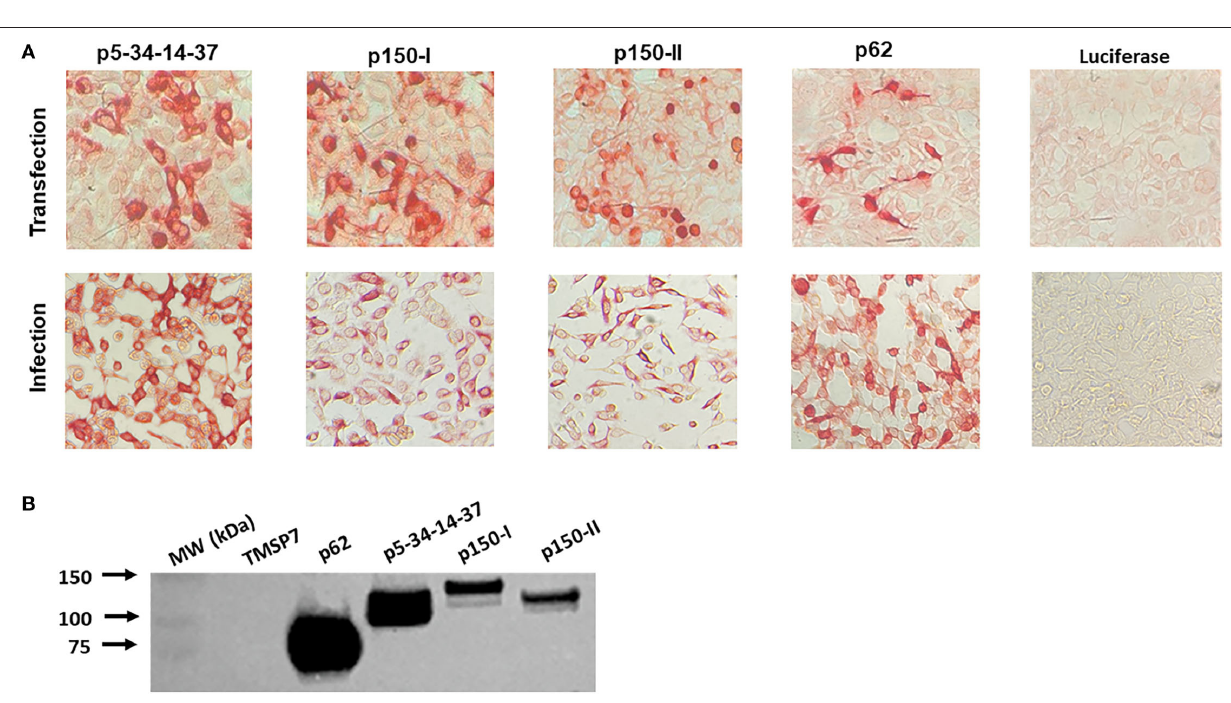
p150-II-specific IFN- γ + splenocytes were detected in the two treatment groups ( Figure 7C